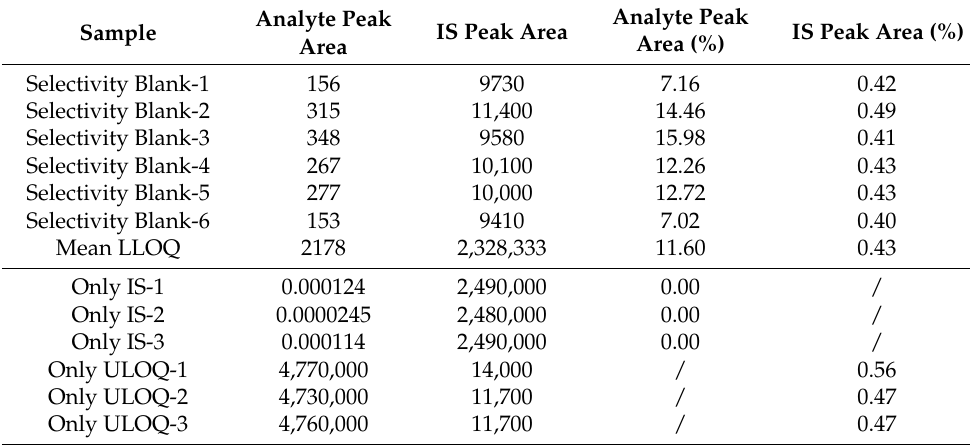
Table 2. Selectivity and Interference of PF and tolbutamide (IS).